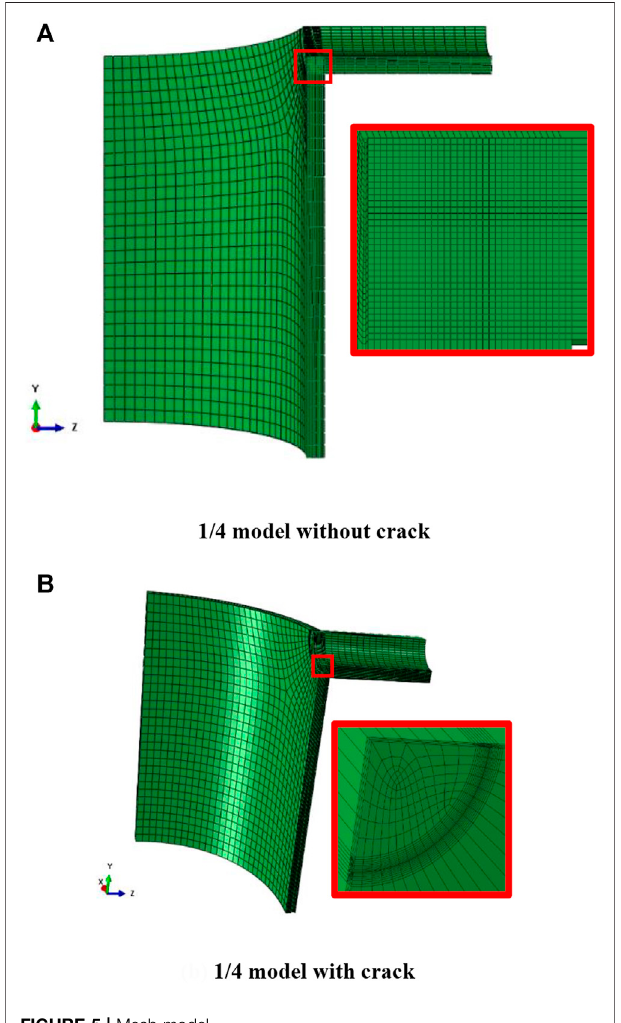
FIGURE 5 | Mesh model.